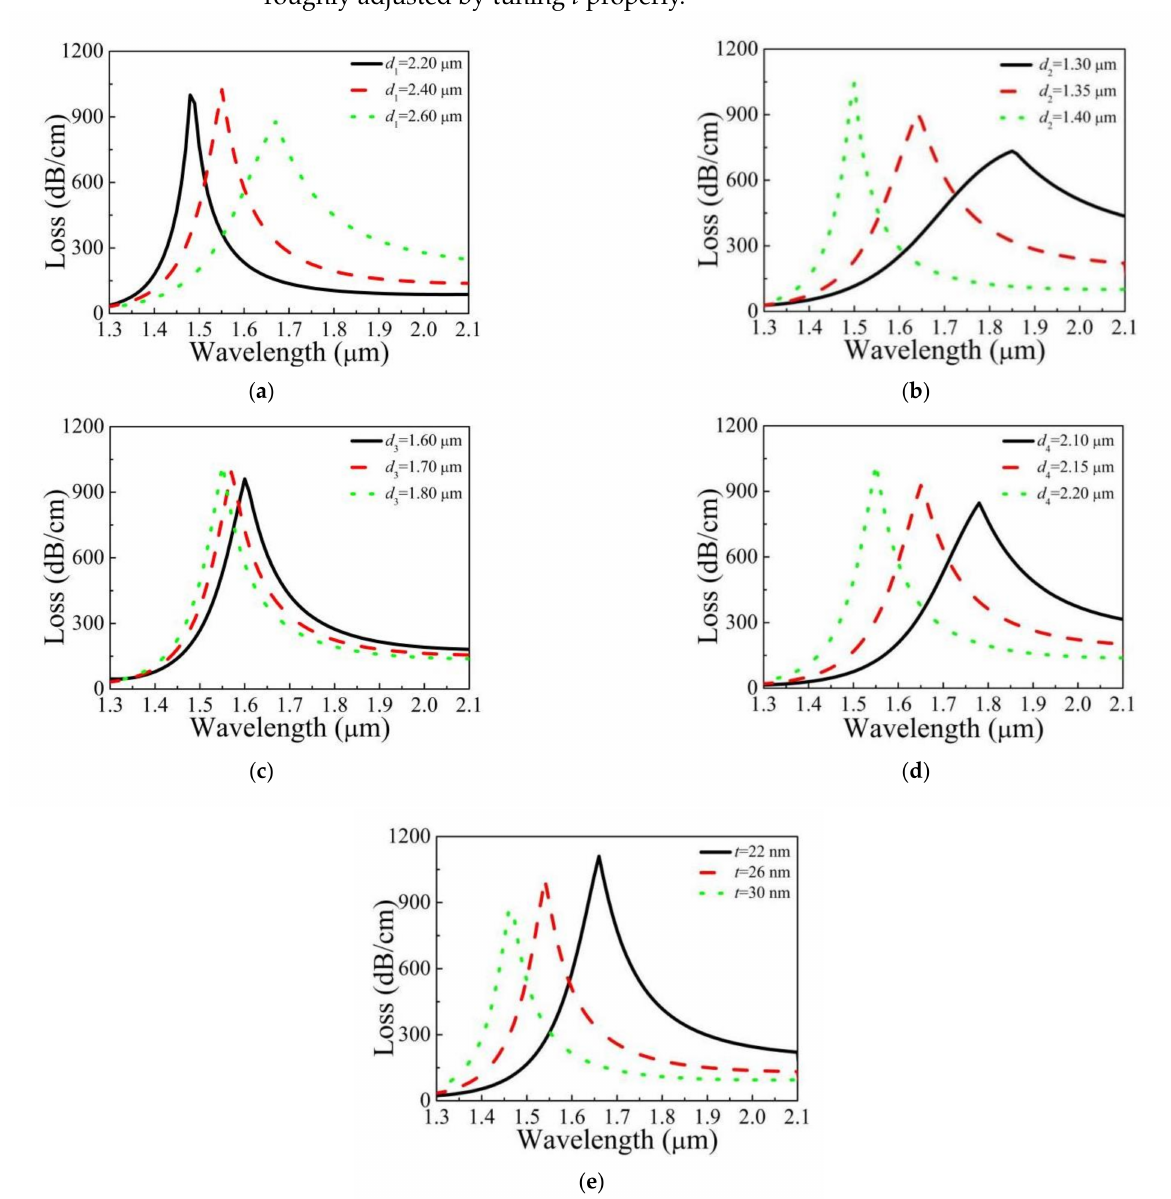
Figure 6. Loss of Y-polarized CM varied with different ( a ) d 1 , ( b ) d 2 , ( c ) d 3 , ( d ) d 4 , and ( e ) t , and other parameters kept